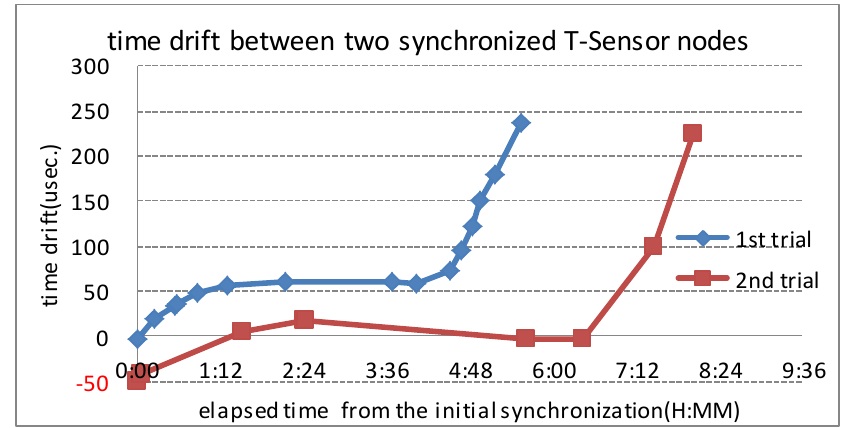
Figure 10. TAR, TACCR0 register alignment for synchronized periodic timer interrupt in 2 T-Sensor nodes.